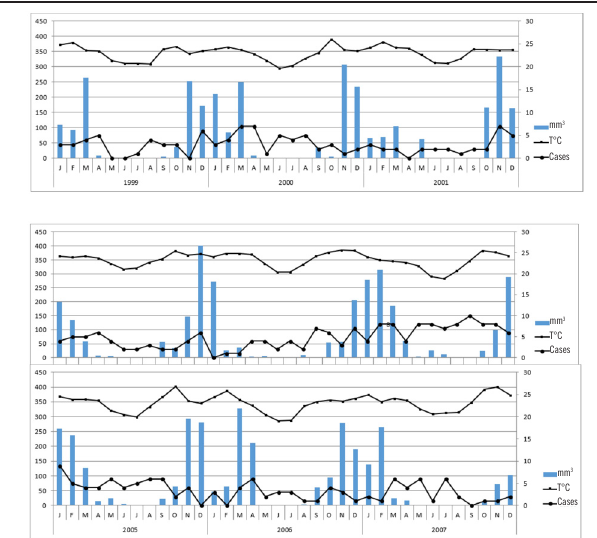
FIGURE 2 – Monthly distribution of VL cases admitted to a referral hospital in the north of Minas Gerais, in addition to monthly averages of average temperature and monthly rainfall, 1999-2007 VL: visceral leishmaniasis.